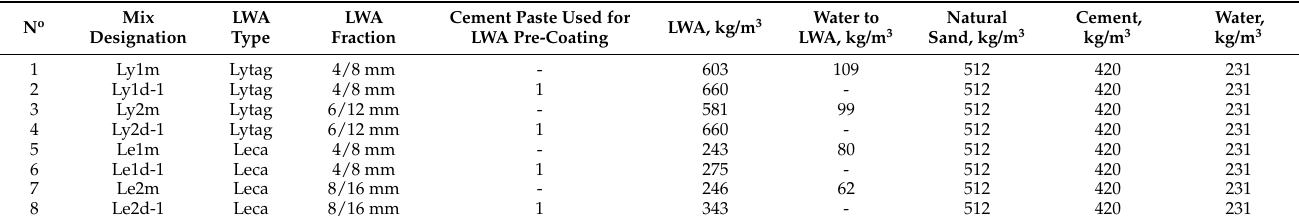
Table 5. Compositions of lightweight concretes prepared with impregnated and non-impregnated